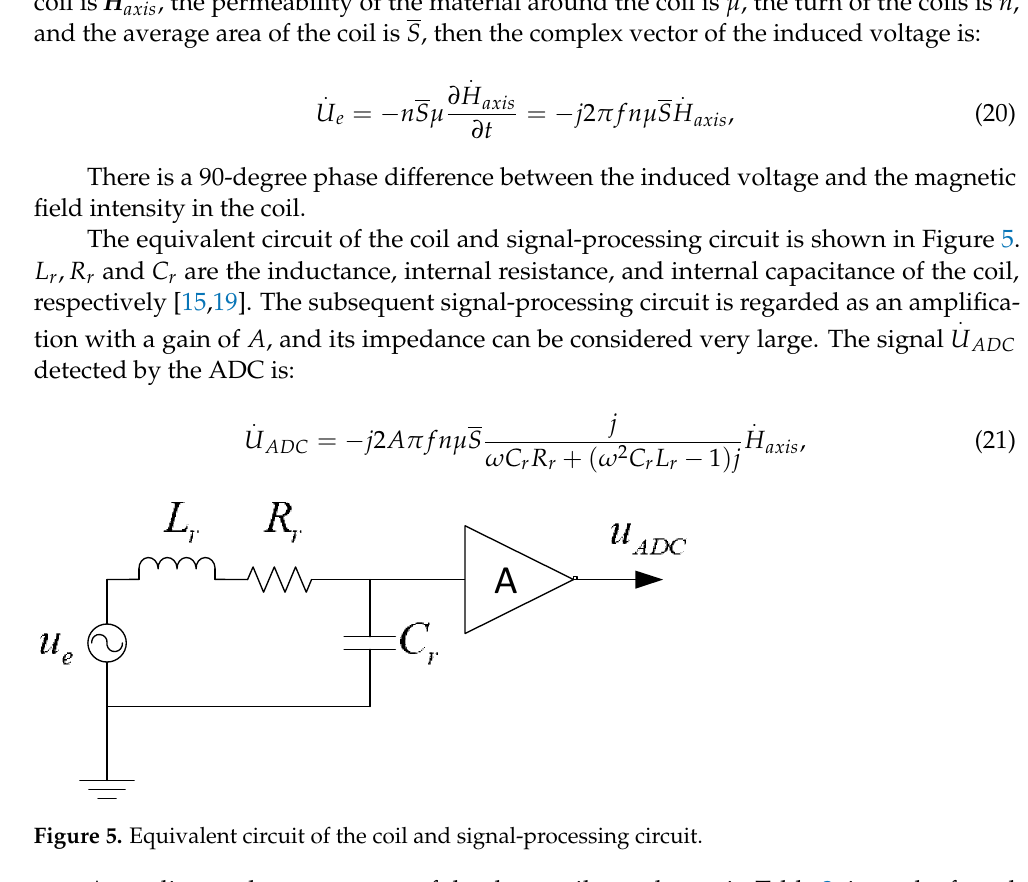
Figure 5. Equivalent circuit of the coil and signal-processing circuit.